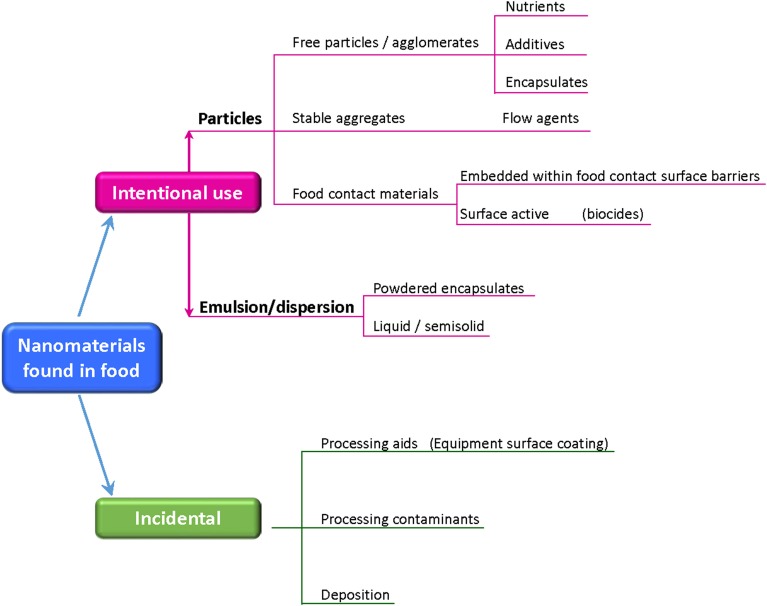
Nanomaterials which might be found in food. (Adapted from http://www.riskscience.org).